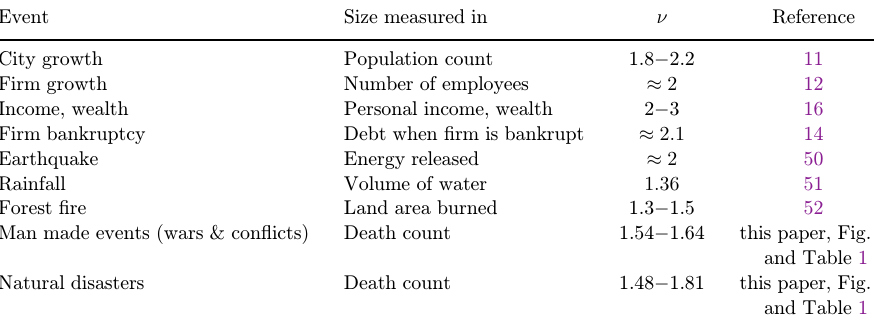
Table 2. Various socio-economic events and their corresponding size exponent (cid:2) for the power law tail of the event size